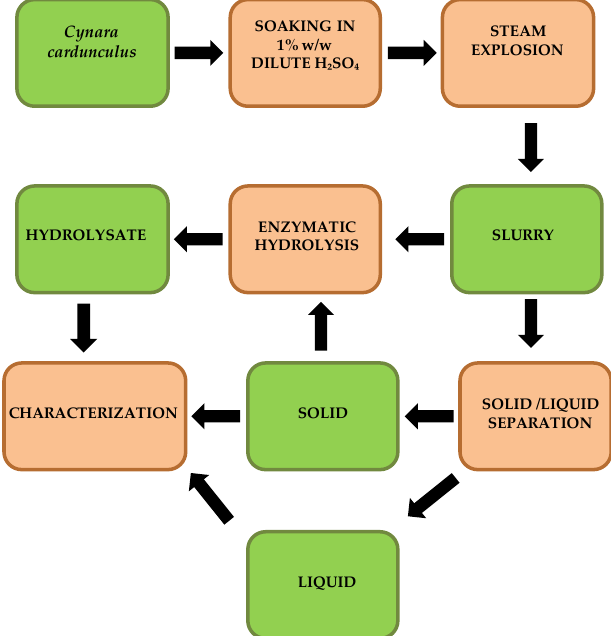
Figure 1. The overall process of the hydrolysates production, starting from Cynara cardunculus biomass.